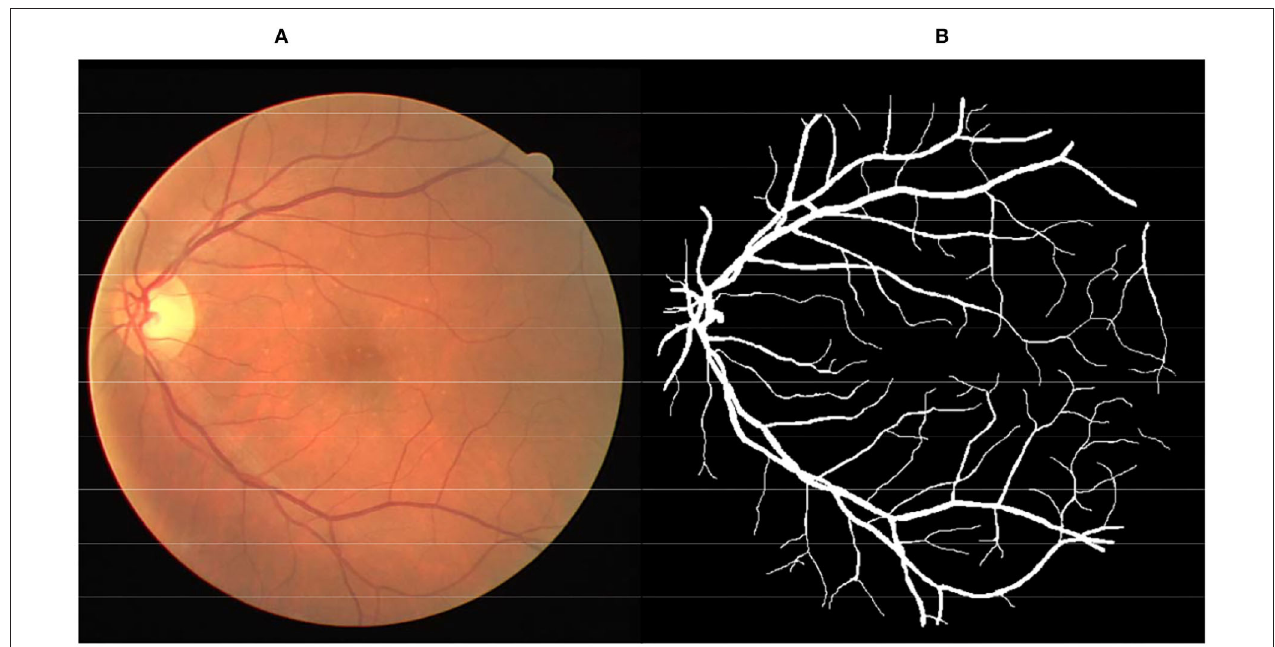
FIGURE 1 | (A) Color fundus image from DRIVE database. (B) Corresponding manual segmented